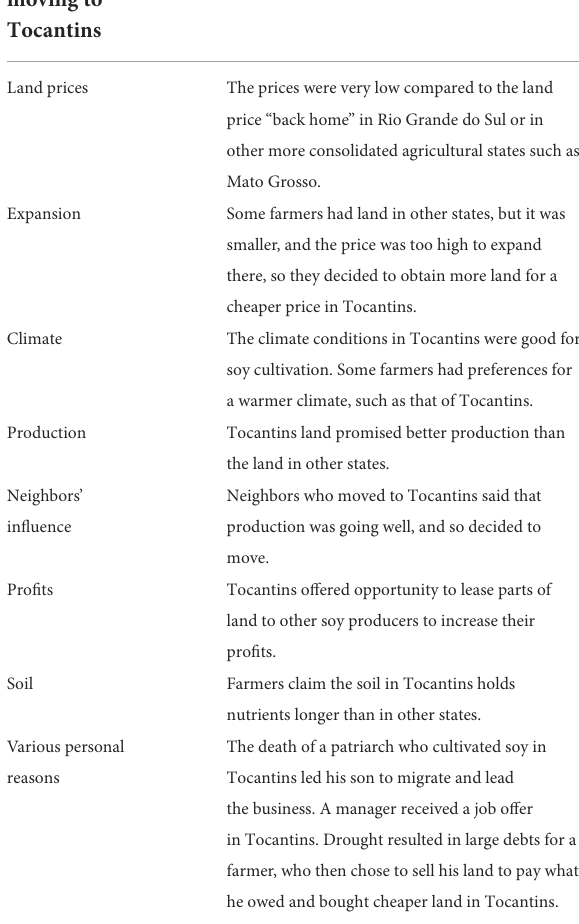
TABLE 4 Reasons why soy farmers migrated to Tocantins State in descending order of the frequency with which each reason was